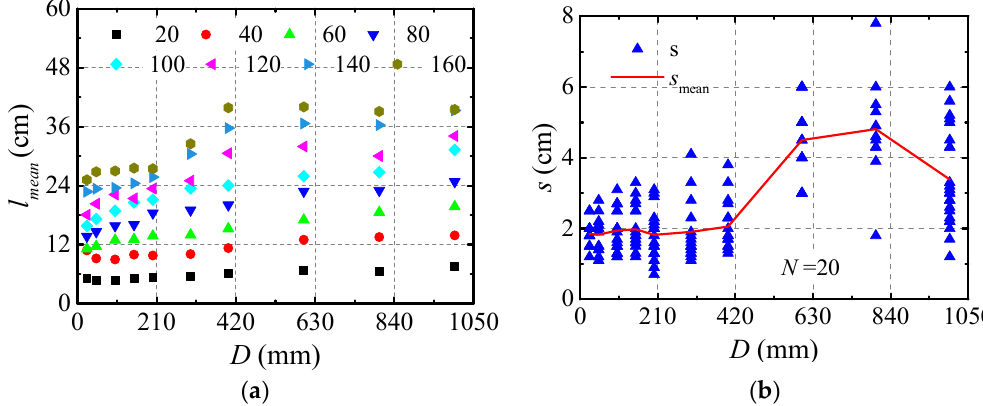
Figure 7. Icicle size of pipeline: ( a ) mean length and ( b ) center-to-center spacing.